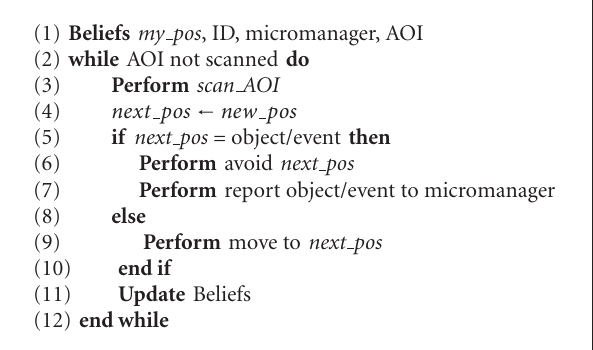
Algorithm 2: Micromanager BDI model.